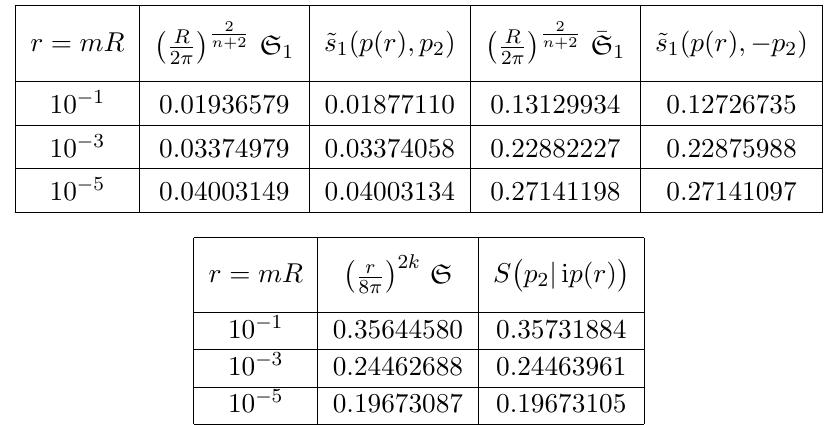
and p 2 = 13 k = 2 4 (cid:0) (cid:1) p 2 j q is found in (5.61). Finally, p ( r )